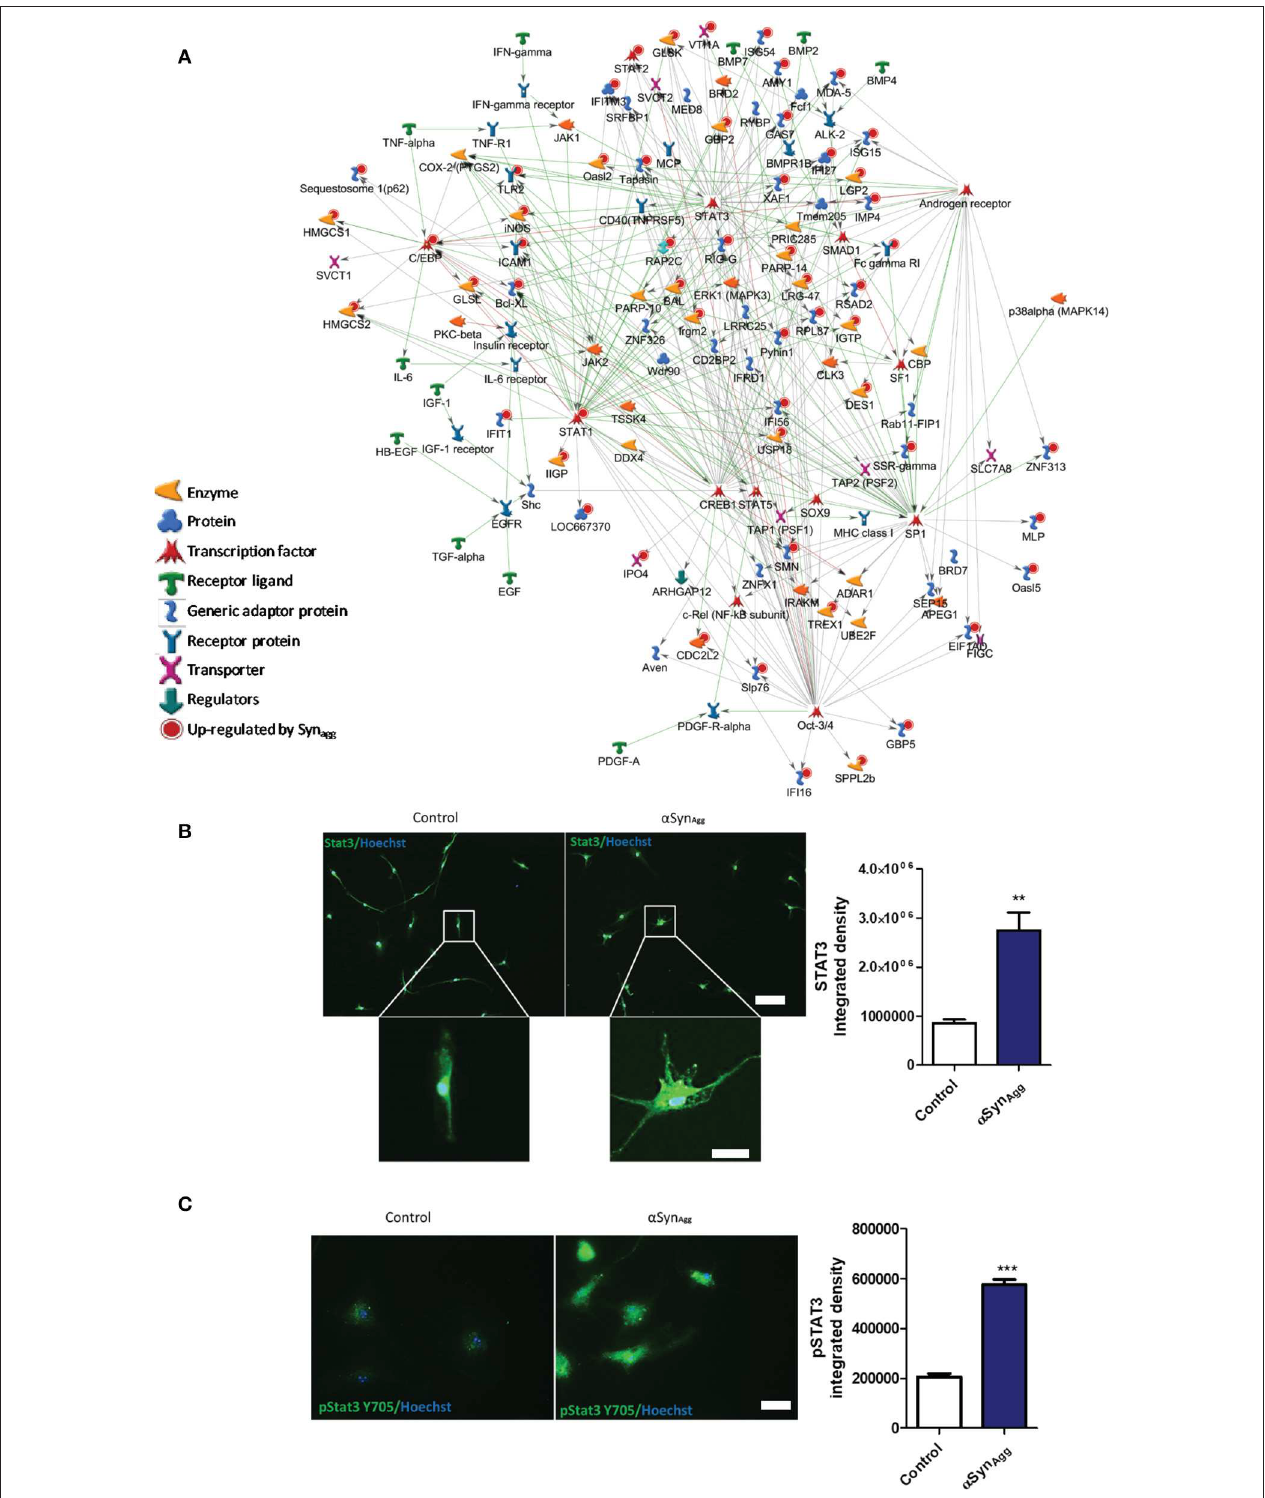
FIGURE 2 | Syn upregulated proteins are downstream of Stat3 and Stat1 signaling pathways. (A) Pathway analysis of the top three Syn-upregulated proteins in microglia. Key immune transcriptional factors including Stat3 and Stat1 are highlighted with Red circles. (B) Confirmation of Stat3 (Scale bar = 100 µ M inset scale bar = 15 µ M) and (C) pSTAT3 upregulation by Syn in primary mouse microglia. Scale bar = 50 µ M. Data analyzed using student’s t -test with n = 4 for each group. ** p < 0.01, *** < 0.005.